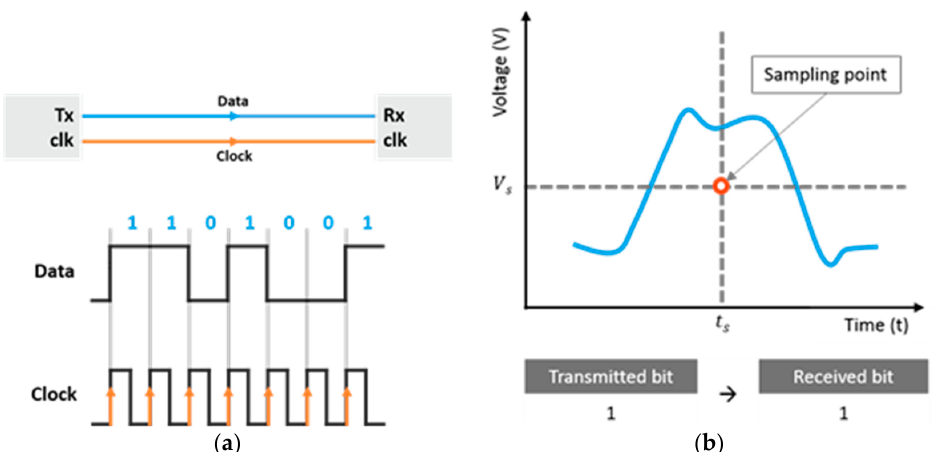
Figure 2. Signal sampling at a receiver. ( a ) data transmission of a synchronous bus ( b ) sampling point at a receiver.